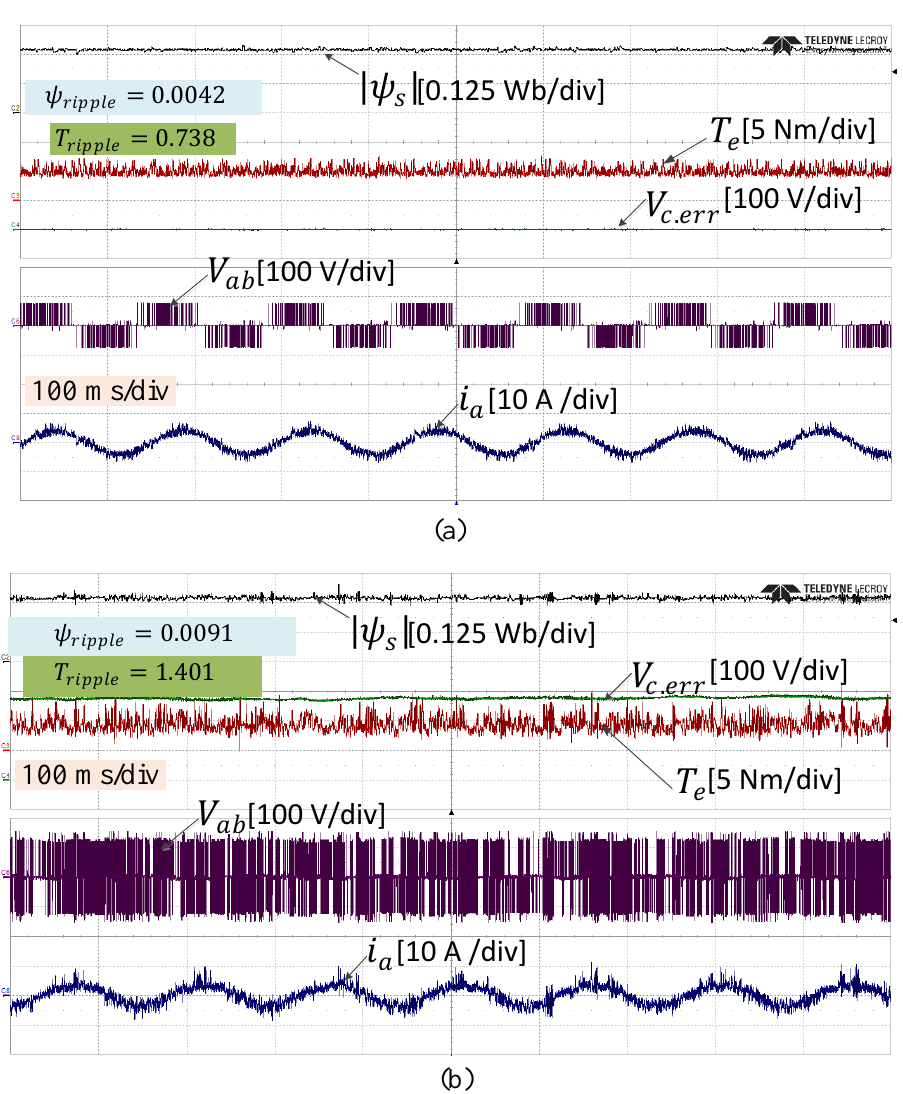
Figure 7. Experimental steady-state response at 100 rpm for ( a ) UFCS-PTC and ( b ) MMPTC.